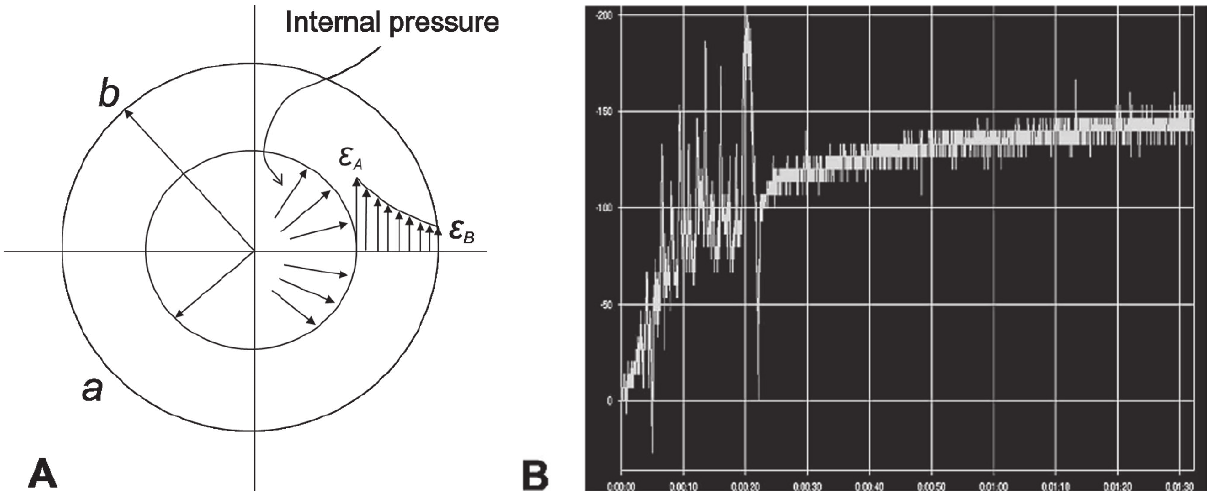
Figure 1 - A: Thick cylinder diagram; B: External root strain induced by the Radix threaded post.